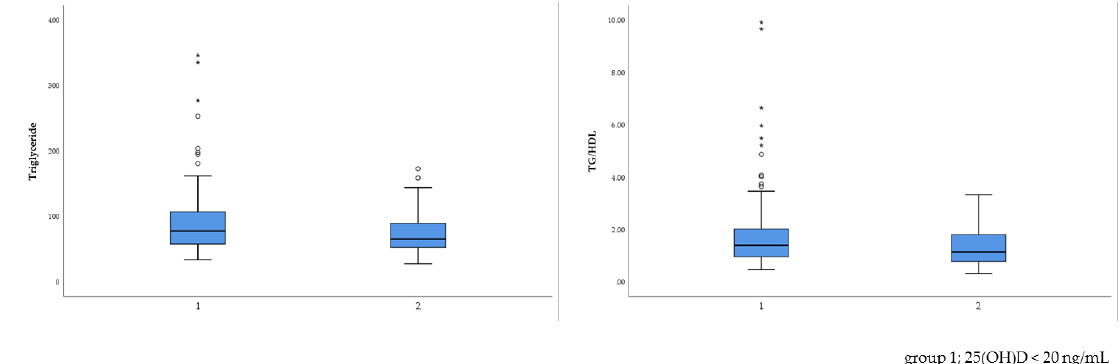
Figure 2. Comparison of the lipid profiles at different vitamin D levels. TG/HDL: Triglyceride to high-density lipoprotein.